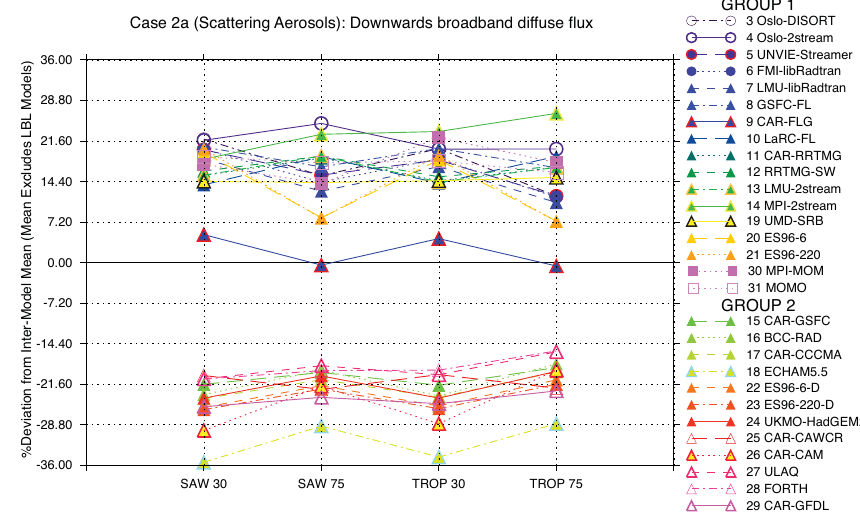
Fig. 3. As a function of standard atmosphere and solar zenith angle, the inter-model diversity in broadband diffuse flux down at the surface for Case 2a (Scattering Aerosols), expressed as a percent deviation from the non-LBL model mean (i.e. all models excluding #1 and 2). Figure A4 shows the inter-model differences in broadband direct and diffuse flux down at the surface for Case 2a and 2b.